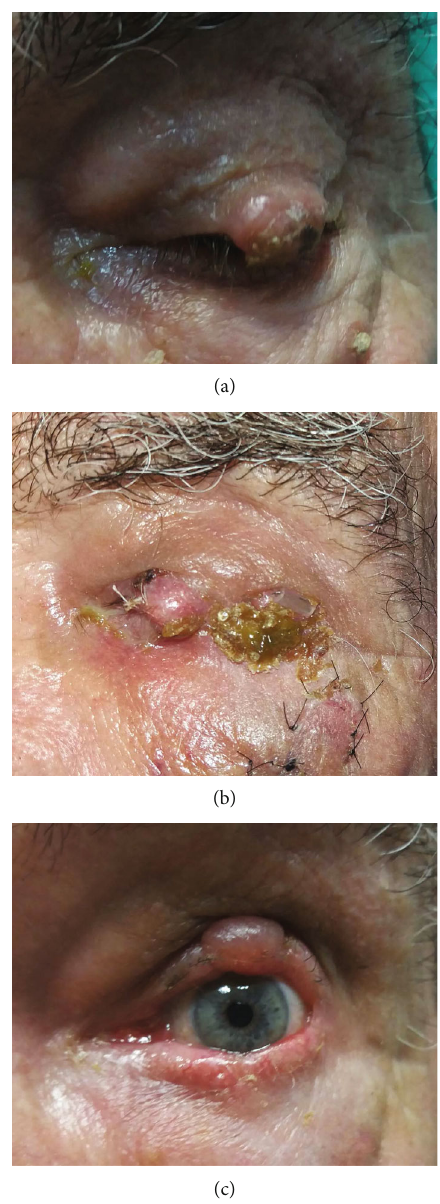
Figure 3: (a) An ulcerated tumor of the lateral half of the upper lid. Note the keratotic plaque at the right bottom of the photo. (b) The fl ap just before the pedicle separation. The nylon sutures of the modi fi ed rhomboid fl ap used for the reconstruction after the keratosis removal still in place. (c) A prolonged Mustardé switch fl ap